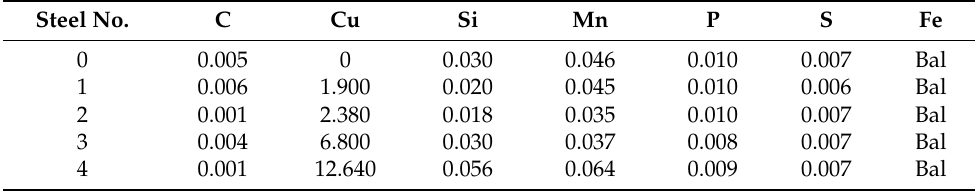
Table 1. Chemical composition of test steel (in